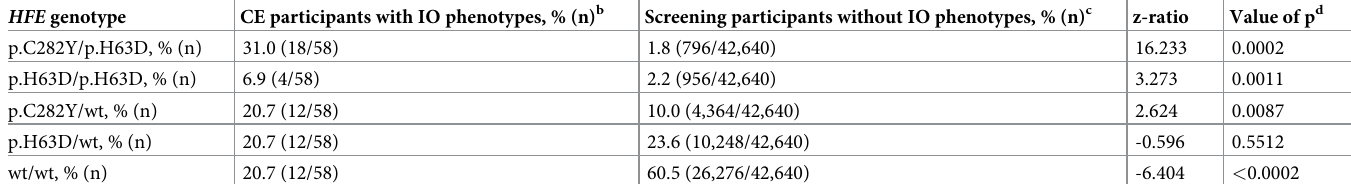
a CE, post-screening clinical examination; IO, iron overload; SF, serum ferritin; TS, transferrin saturation; wt, absence of HFE p.C282Y and p.H63D. b IO phenotypes were defined as elevated SF (men > 300 μ g/L, women > 200 μ g/L) and elevated TS (men > 50%, women > 45%) at screening and CE.